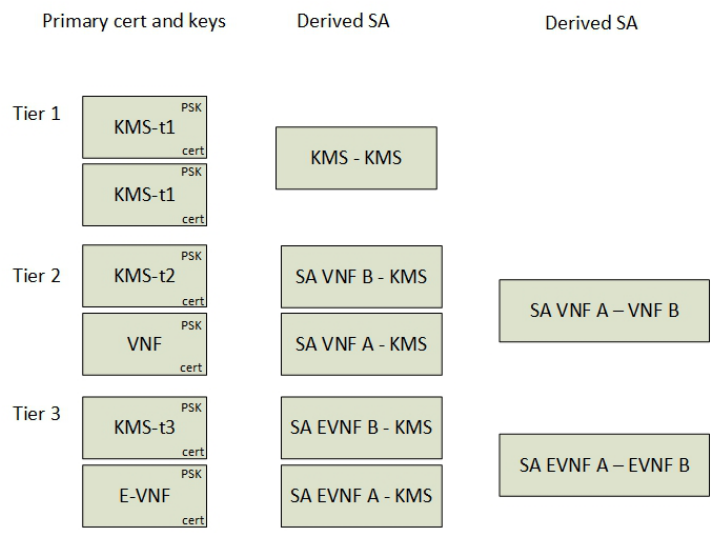
Figure 13. Overview of the encryption